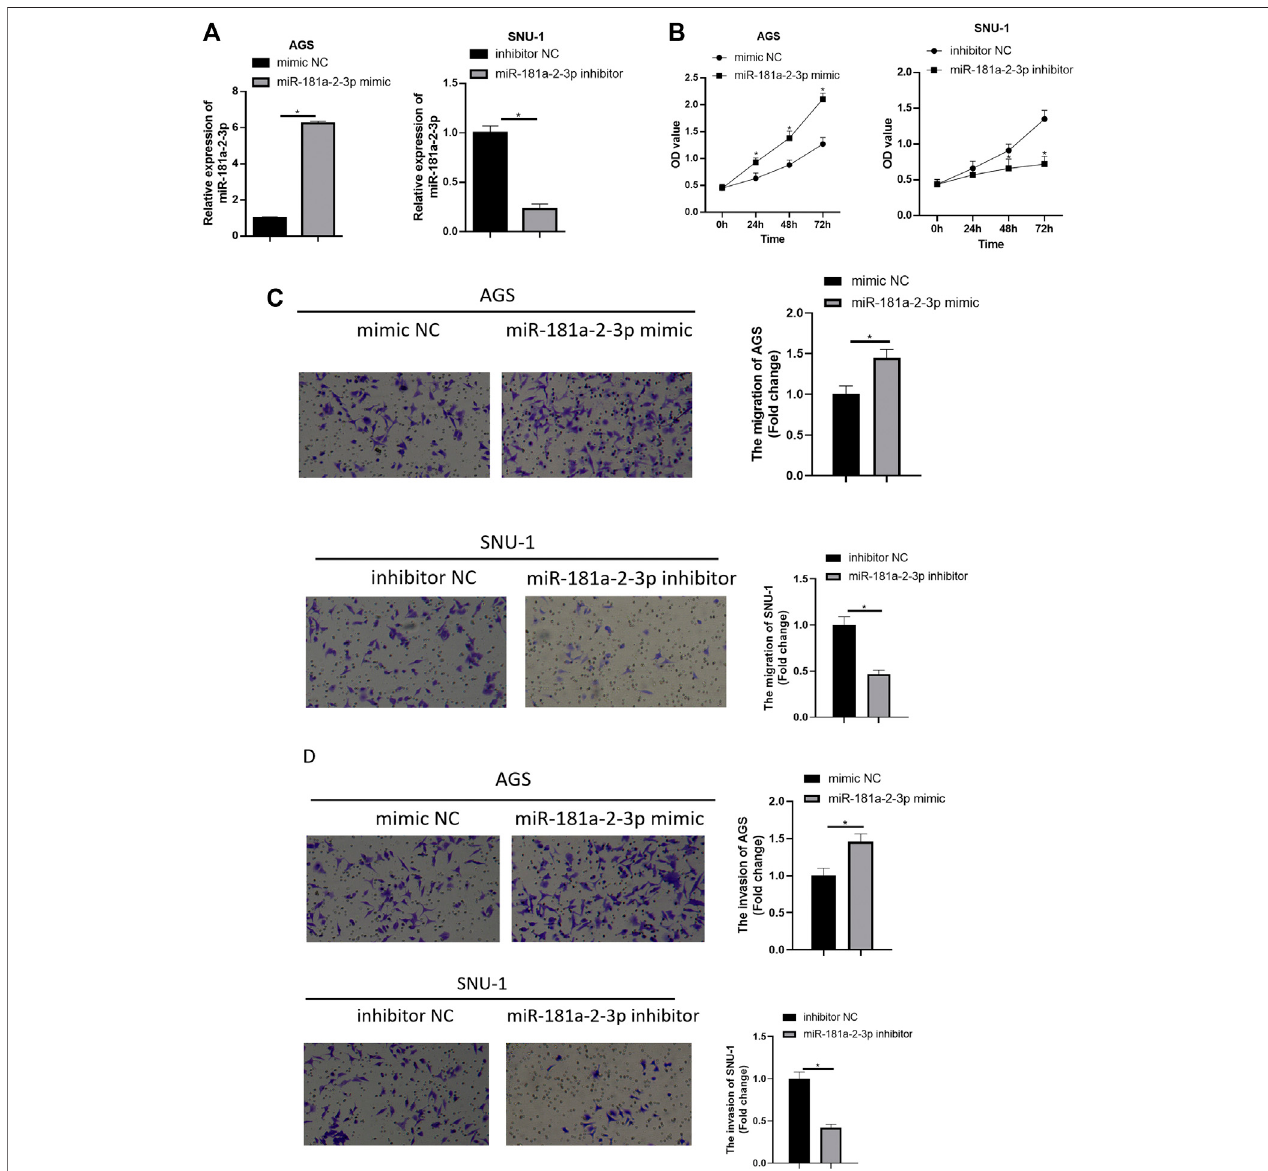
FIGURE 2 | Overexpressing miR-181a-2-3p promotes GC cell progression while silencing miR-181a-2-3p exerts an opposite effect. (A) qRT-PCR assayed miR- 181a-2-3p in SNU-1 and AGS cells with varying treatments; CCK-8 and Transwell assays (100 × ) were performed to measure (B) cell viability, (C) cell migration and (D) invasion of AGS and SNU-1 cells; * p <